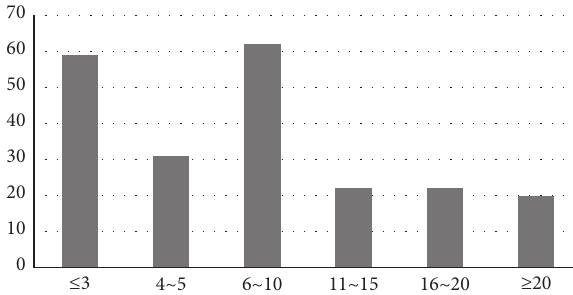
Figure 3: Distribution of driving experience of drivers in accidents.